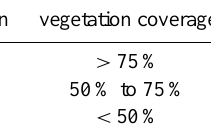
Table 1. The relationship between hydrological condition and vegetation coverage. hydrological condition vegetation